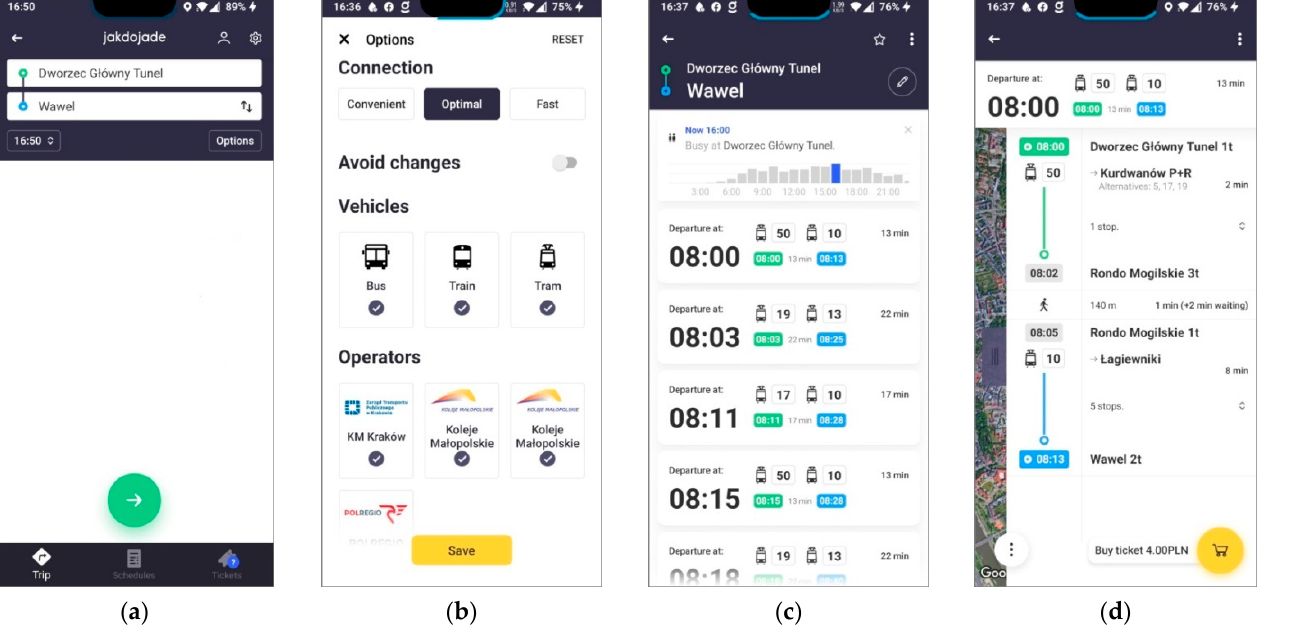
Figure 2. Overview of selected Google Transit tabs: ( a ) public transport options, route options; pre- ferred modes; ( b ) the tab with information about possible connections between the defined points.